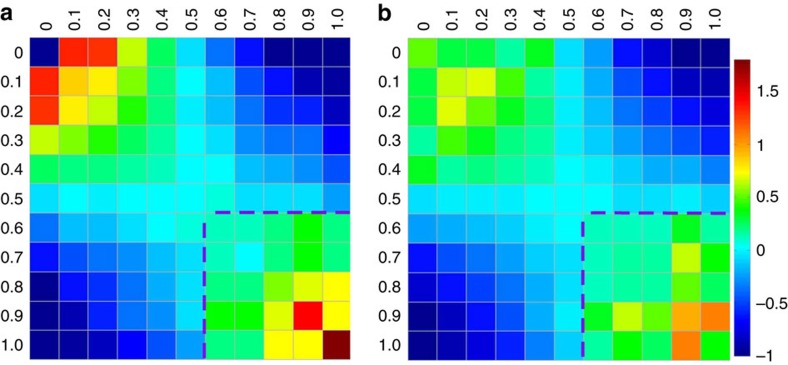
Correlation matrix of atoms with diverse W.Correlation matrices of Cij between atoms classified into diverse W in (a) Cu46Zr46Al8 and (b) Mg65Cu25Y10 at T=1.2Tg (the behaviour of Cij is similar at different temperatures).